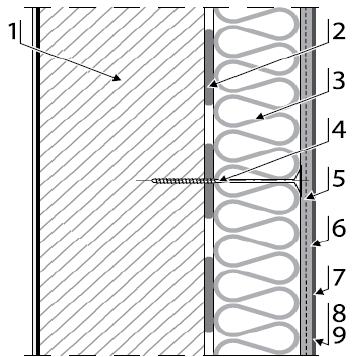
Figure 1. Layers arrangement in the ETICS system as described: (1) wall structure (substrate), (2) adhesive (basic fixing), (3) thermal Insulation (EPS), (4) anchor (if necessary, additional fixing), (5) reinforcement layer (base coat with glass fiber mesh embedded), (6) key coating (if necessary), (7) finishing coat (renders), (8) primers (optional), and (9) decorative coats (optional). Table 1. EITCS system components as described in the National Technical Approval ITB AT-15-9090 / 2016. Category Component Description Cement-based adhesives modified Adhesives for bonding the EPS